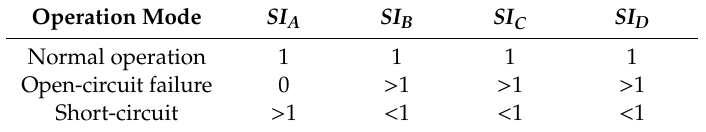
Table 1. Values of the Diagnostic Variables for the Several Operation Modes Associated with Phase A.